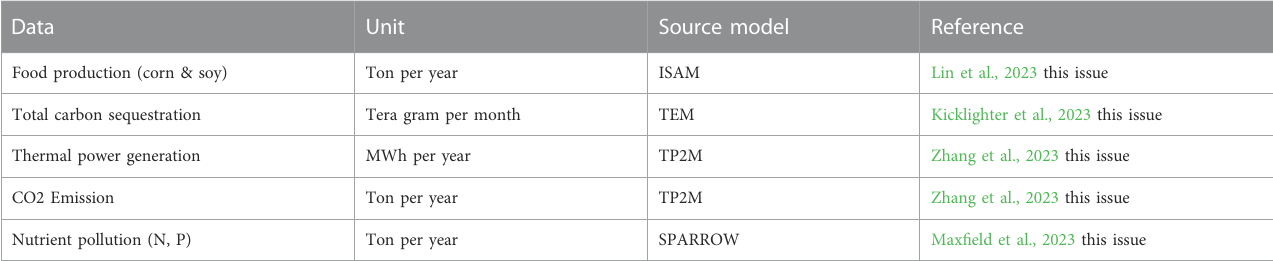
TABLE 5 Sources of data on C-FEWS portfolio